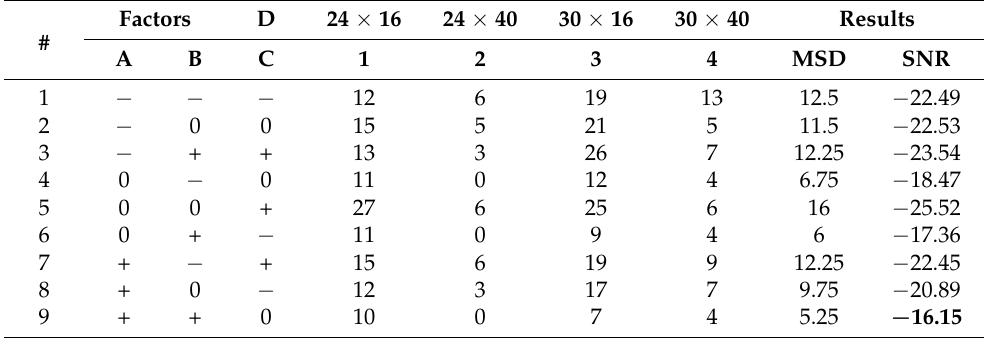
Table 2. Combination of factors and the resulting values of the trials of experiments (Group #1).